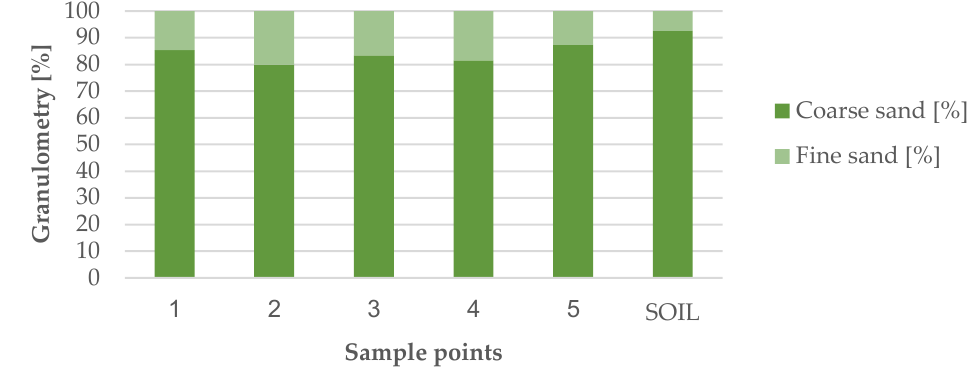
Figure 8. Variation in coarse and fine sand in the samples, Băiuț mining area [%] .